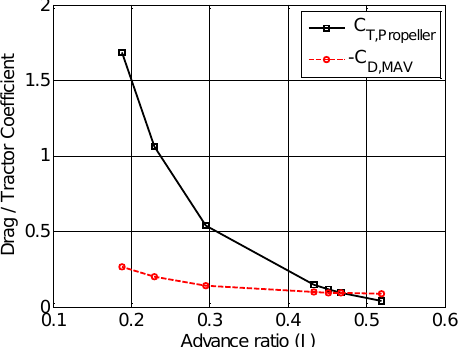
Figure 5. Drag and tractor coefficient with a function of advance ratio.